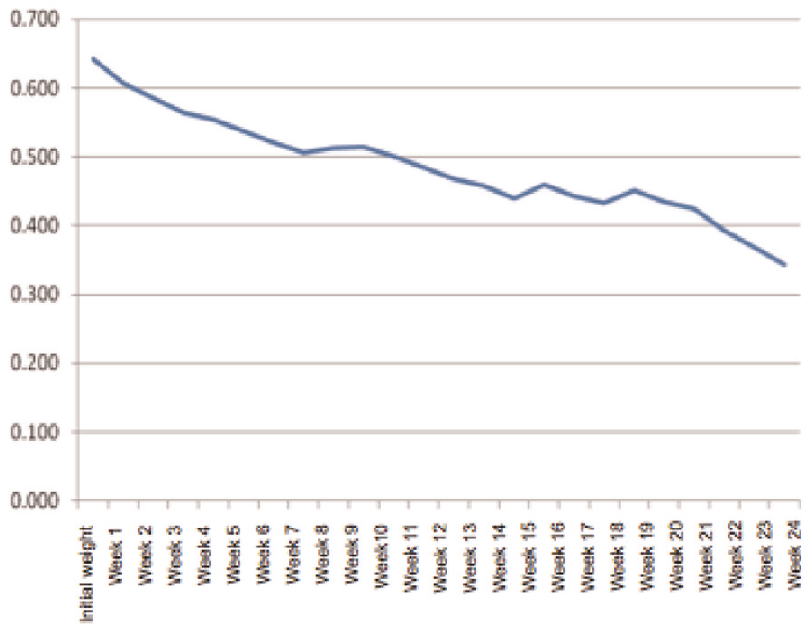
Figure 2 - Curve of relative effects of treatment. The impact of each of the consecutive weekly weight variations on the final treatment result is shown. The abscissae axis shows the time of treatment in weeks and the ordinate axis shows statistical significance of the weight variation. After the 14th week, the weekly weight variation lost statistical